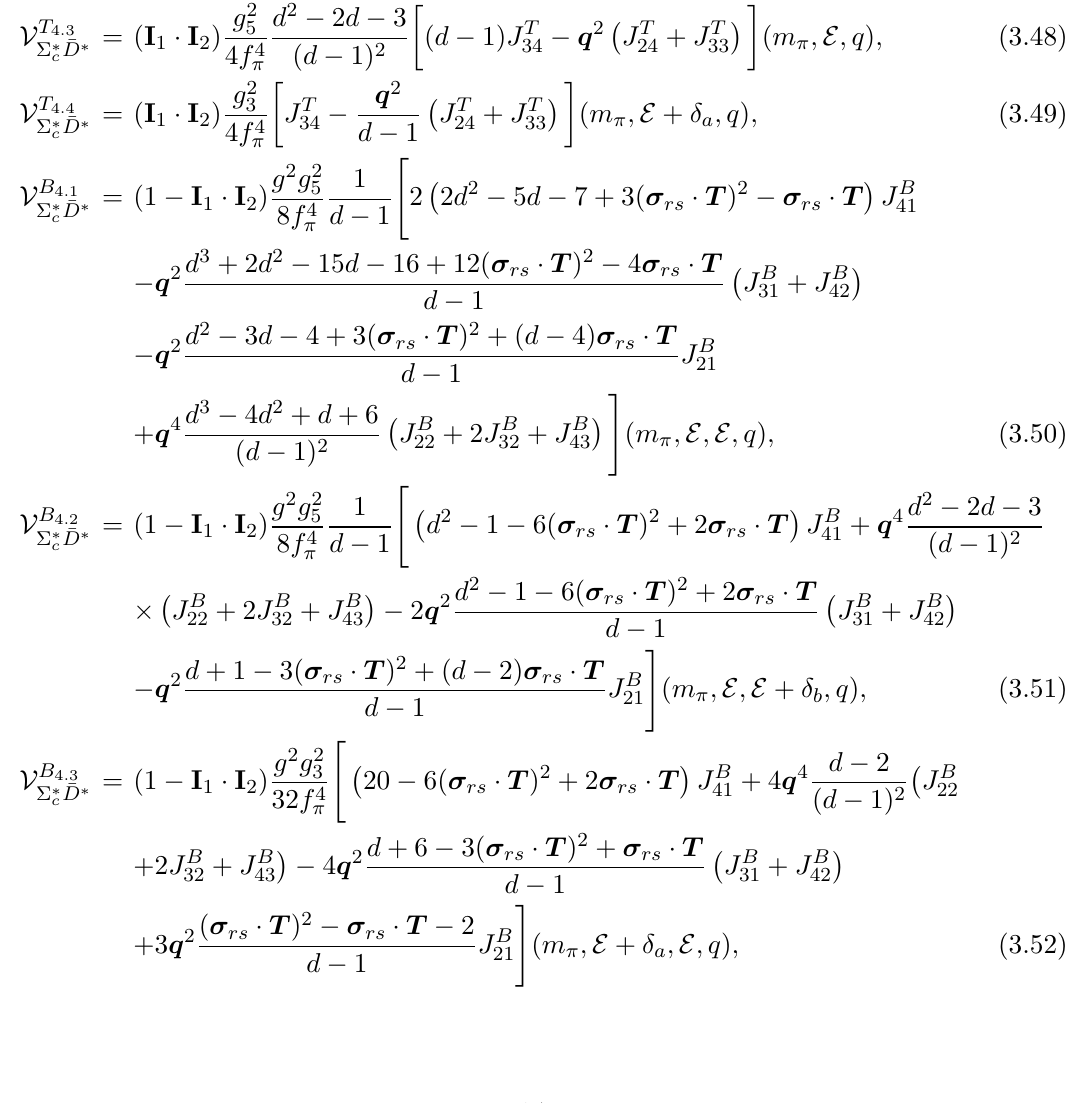
Figure 7 . The two-pion-exchange diagrams of the (cid:6) (cid:3) baryon lines in diagrams ( T 4 : 4 ), ( B 4 : 3 ), ( B 4 : 4 ), ( R 4 : 3 ) and ( R 4 : 4 ) can also be the (cid:3) c . The notations are the same as those in (cid:12)gure